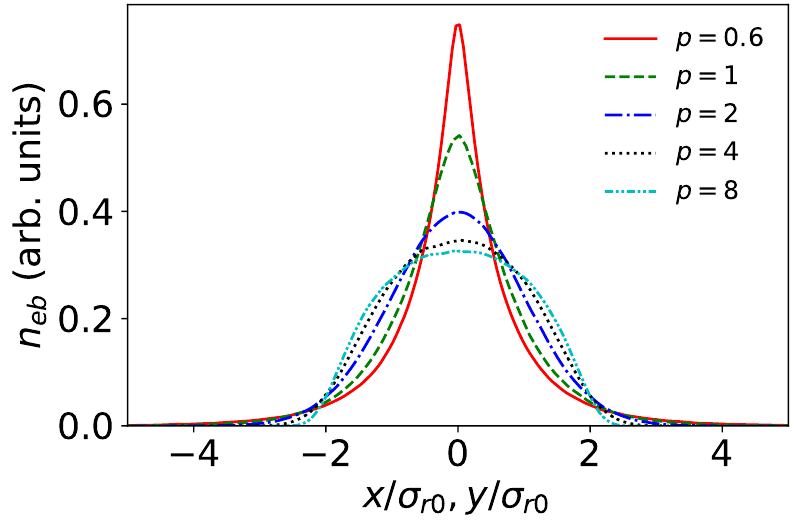
Figure 4. 1D transverse beam density distributions in generalized Gaussian function. p is the form parameter. All distributions have the same standard deviation σ r 0 .